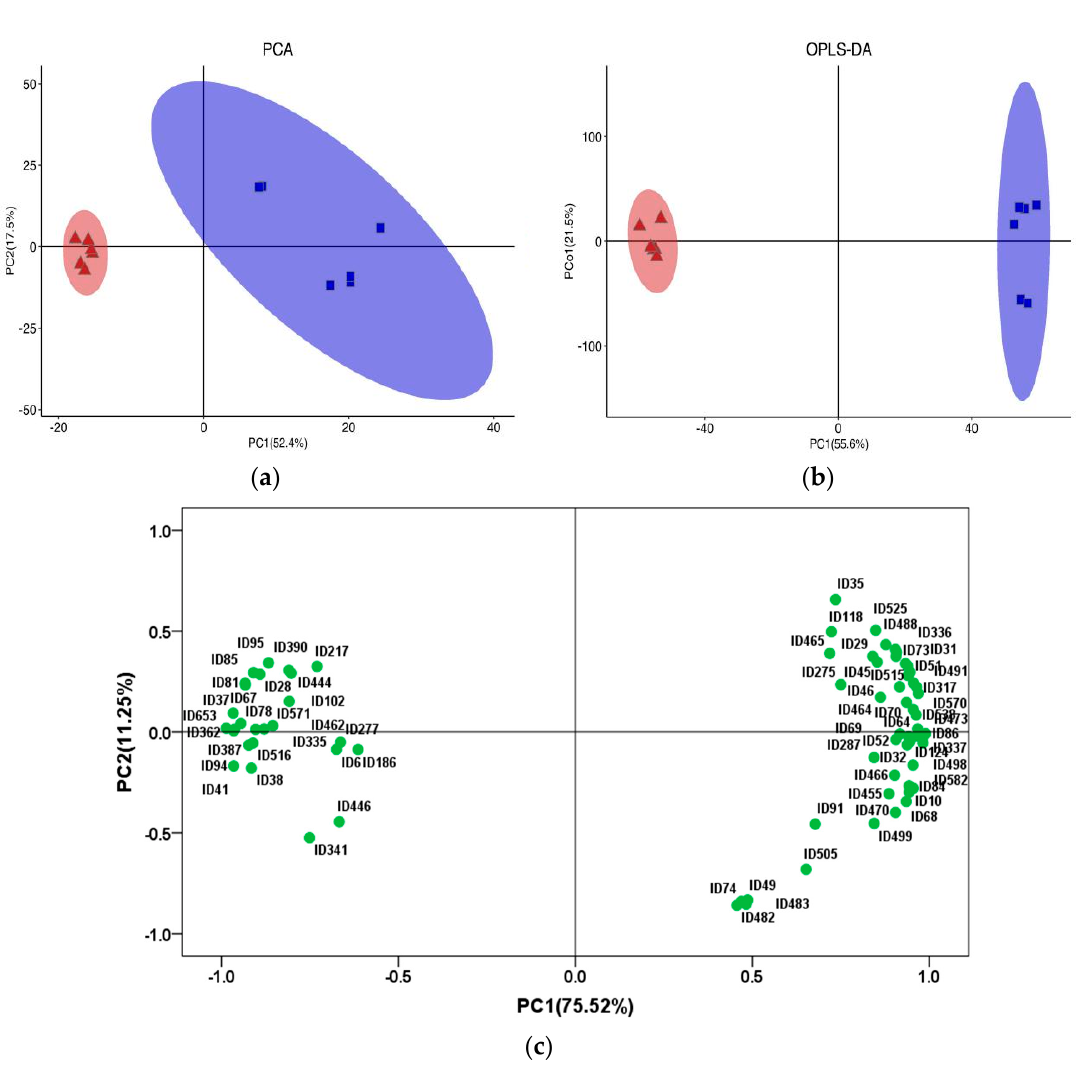
Table 2. The information on crucial lipids resulting in the lipid differences in yak LD between GF and SF groups.